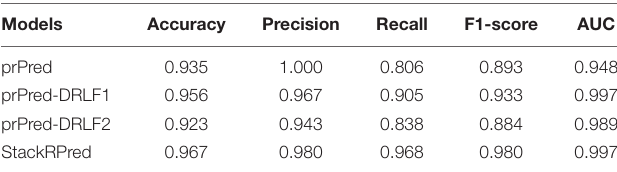
TABLE 3 | Performance comparison with other state-of-the-art prediction methods on independent datasets. Models